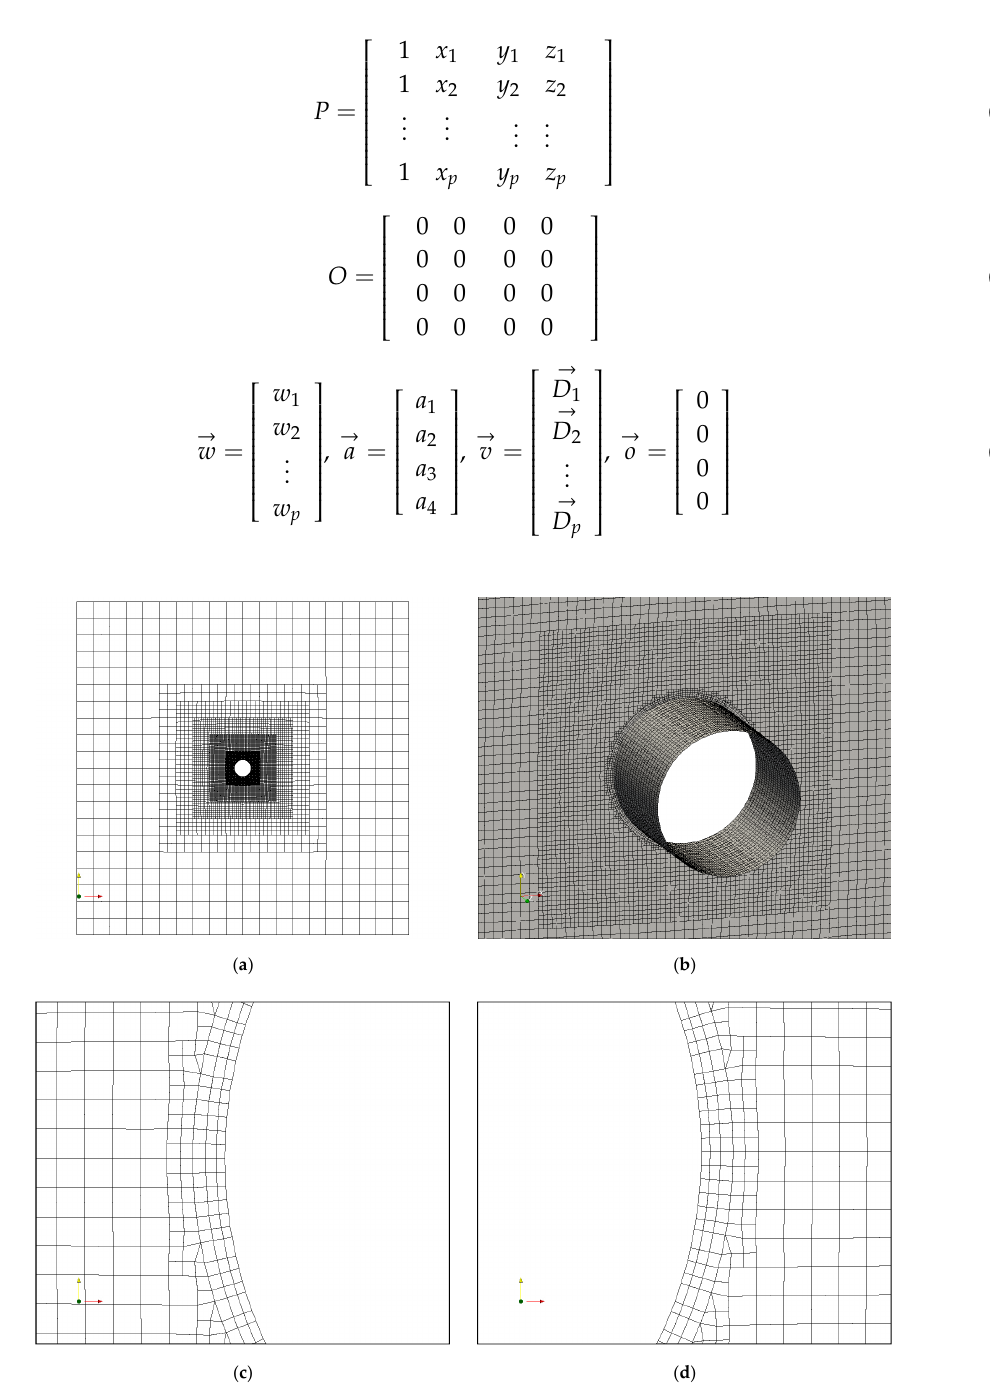
Figure 3. Initial grid shape for circular cylinder. ( a ) whole domain (side view), ( b ) surface mesh (perspective view), ( c ) around front part of the body (leading edge), ( d ) around rear part of the body (trailing edge).